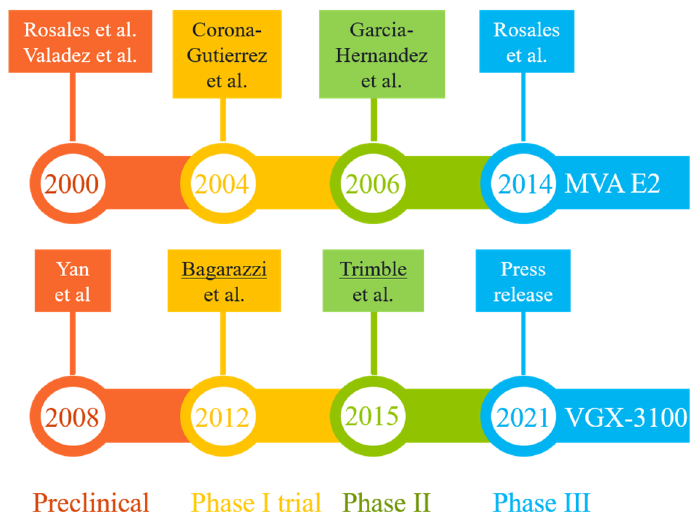
Figure 3. Milestones in the R&D paths of two promising vaccine candidates (MVA E2 and VGX-3100) that have completed phase III clinical trials in patients with HPV-related pre-cancerous conditions (mostly high-grade squamous intraepithelial lesions). The results from key developmental stages are readily available in peer-reviewed publications [79,80,83,93–95,97,98,100] or online resources [84,99]. The lead authors of two highly cited studies (more than 250 citations each) are underlined.